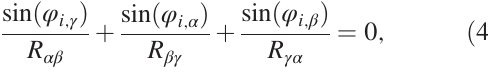
ffiffiffiffiffi ffiffiffiffiffi p d p d p p β β ¼ γ γ